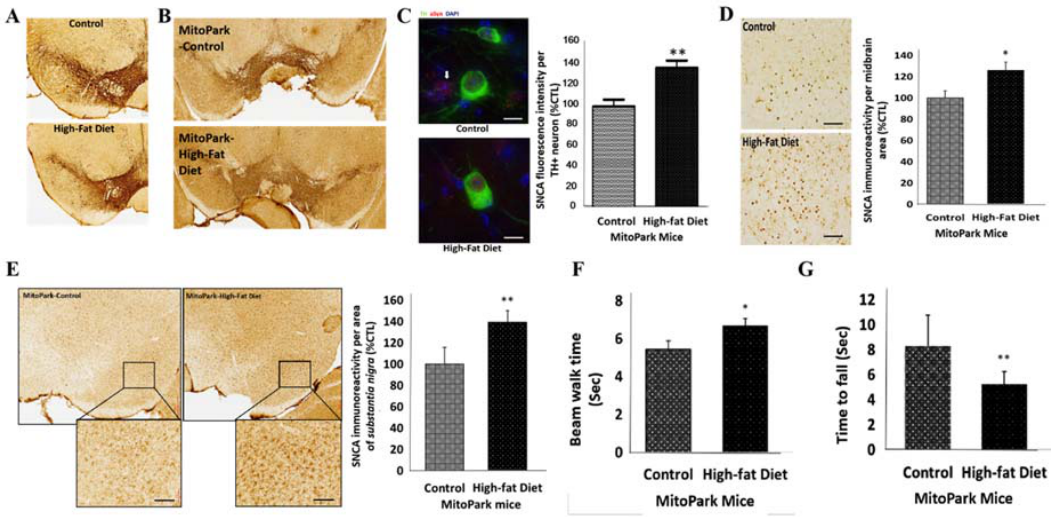
Figure 2. Diabetes contributes to the progression of PD by amplifying the loss of tyrosine hydroxylase (TH) + dopaminergic neurons and enhancing α‐ synuclein (SNCA) expression, in vivo. ( A ) Representative IHC images of TH immunoreactivity in the midbrain substantia nigra of high ‐ fat diet ‐ induced diabetes C57BL/6 mice compared to the control mice. ( B ) Representative IHC images of SNCA immunostaining in the substantia nigra of diabetic MitoPark mice, compared to their control non ‐ diabetic counterparts. ( C ) Representative immunofluorescence images of α‐ syn/SNCA (red) and TH (green) expression in the midbrain of control and diabetic MitoPark mice, captured by deconvolution microscopy. 4 ′ ,6 ′‐ diamidino ‐ 2 ‐ phenylindole (DAPI) serve as nuclear staining (left). Graphical representation of the SNCA fluorescence intensity in TH ‐ positive dopaminergic (DA) neurons from diabetic MitoPark mice (control: 100 ± 6.6%, diabetic: 137.7 ± 8.2%, n TH + neurons = 24, p < 0.01) (right). ( D ) Representative images (left) and graphical representation (right) of SNCA immunoreactivity in the midbrain tectum of control and high ‐ fat diet ‐ induced diabetes MitoPark mice (control: 100 ± 8.7%, diabetic: 126 ± 7.6%, n = 3). ( E ) Representative IHC images (left) and graphical representation (right) of SNCA expression in the substantia nigra of control and high ‐ fat diet ‐ induced diabetes MitoPark mice (control: 100 ± 15.7%, diabetic: 139.2 ± 10.9%, n = 3). *, p < 0.05, **, p < 0.01; control, non ‐ diabetic mice. ( F ) Diabetic MitoPark mice took a longer time to walk the beam compared with control MitoPark mice (control: 5.43 ± 0.46, diabetic: 6.67 ± 0.39 s, n = 3). ( G ) Diabetic MitoPark mice stayed a shorter length of time on the rotarod tests (control: 8.3 ± 2.5, diabetic: 5.3 ± 1 s, n = 3).